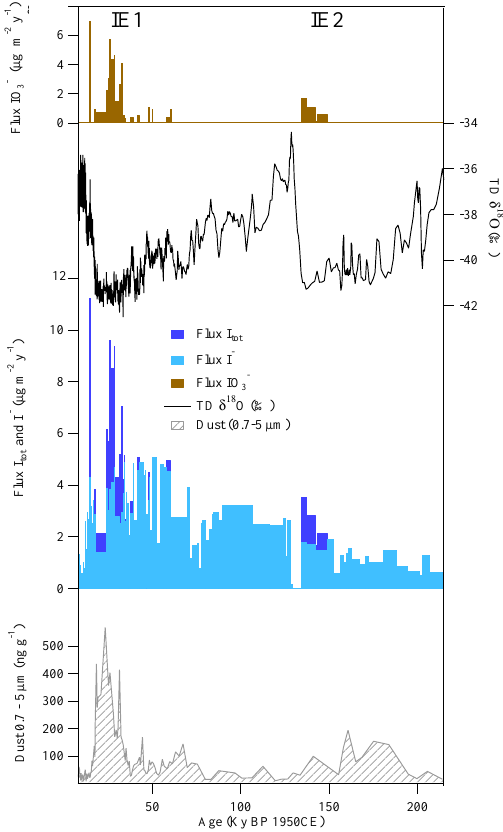
Fig. 8. Iodate (IO − ,brown), iodide (I − , light blue) and total iodine 3 (I tot , blue) in Talos Dome ice core samples. While I − is present in all samples, IO − is closely linked with the fine dust load (grey 3 shaded area, Delmonte et al., 2004) and is present only from 16.8 to 33.8ky BP and 134.2 to 143.2ky